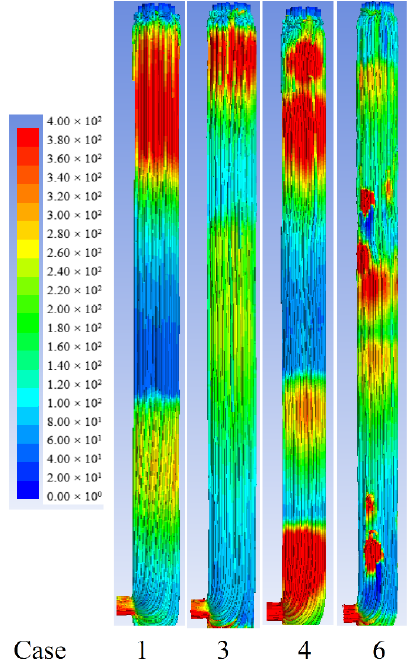
Figure 10. Turbulent intensity for selected cases.